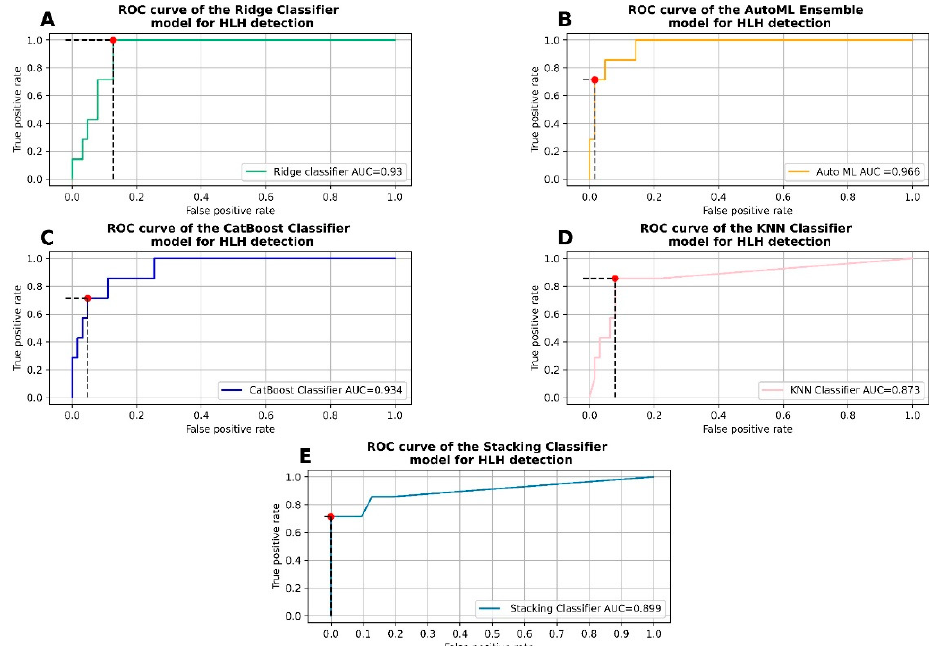
Figure 1. Receiver operating characteristic curves for the five different algorithms used for HLH detection. ( A ) AutoML ensemble model, ( B ) ridge classifier, ( C ) CatBoost classifier, ( D ) K nearest neighbors (KNN) classifier, and ( E ) stacking classifier with XGBoost as a meta-estimator. Red dots are used to mark the true positive rate and the false positive rate at the threshold used for